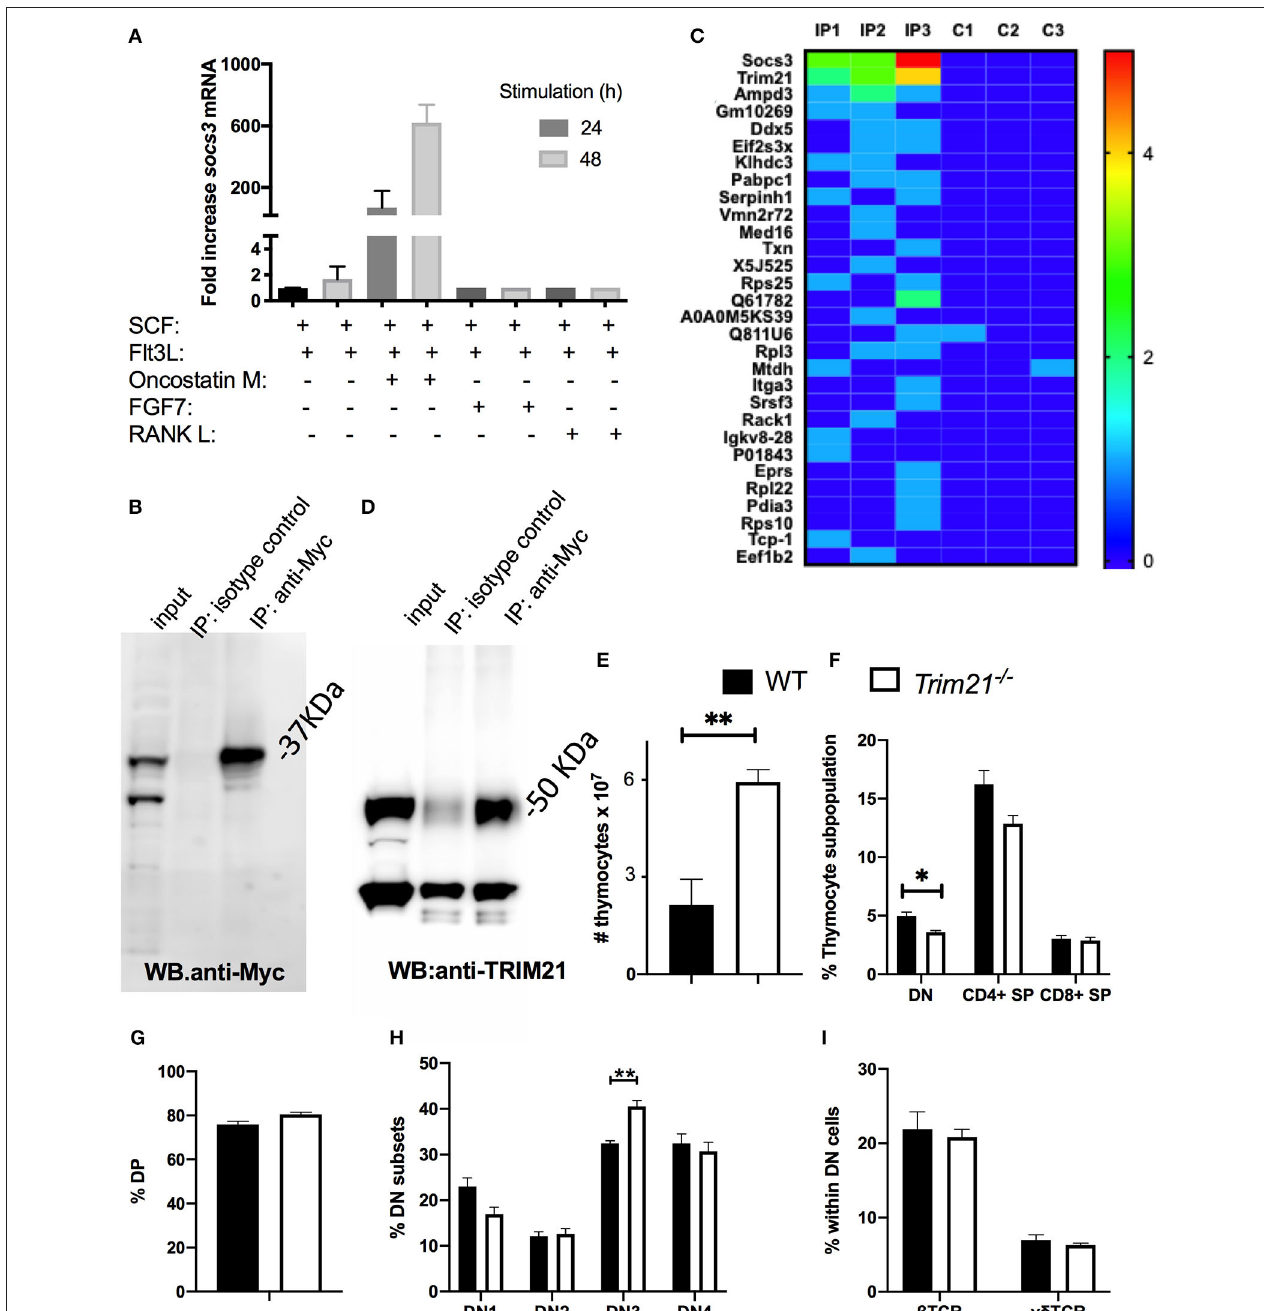
FIGURE 6 | SOCS3 in thymic epithelial cells binds to TRIM21. (A) OP9-DL1 cells were incubated with either SCF, Flt3L, OMS, FGF7, or RANK. Twenty four and forty eight hour after stimulation, the total mRNA was extracted and Socs3 and Hprt mRNA levels measured by real time RT-PCR. The mean relative fold induction of Socs3 / Hprt mRNA ratio in stimulated and unstimulated cells are depicted. (B) OP9-DL1 cells were transfected with an Myc-SOCS3 plasmid. The western blot of transfected cell lysates before and after immunoprecipitation with anti-myc or an isotype controls is shown. (C) Heat map of ranking proteins identified after tandem mass spectrometry in immunoprecipitates from socs3- transfected OP9-DL1 cells with anti-myc or isotype controls. Three replicates per condition were analyzed. Ranking was calculated with an algorithm weighing the number of replicates in which the protein was detected in the IP and in the control group, the number of peptide spectral matching the protein, the number of unique peptides and the intensity (the area under the curve). (D) Anti-SOCS3 or anti-isotype immunoprecipitates were analyzed by immunoblot using anti-TRIM21. (E) The mean number of WT and Trim21 − / − thymocytes ± SEM are depicted ( n ≥ 5 per group). Differences between groups are significative (** p ≤ 0.01 unpaired Student’s t -test). (F,G) The mean frequency of thymic DN, DP, and SP subpopulations ± SEM in Trim21 − / − and WT thymi ( n = 5 per group). (H) The mean of frequency ± SEM of DN1-DN4 subpopulations (defined by CD44 and CD25 expression) in trim21 − / − and WT thymi (n ≥ 5 per group). (I) The mean % of β and γδ TCR + cells within the DN thymocytes of WT and trim21 − / − mice ( n ≥ 5 per group). Differences between groups are significant at ** p ≤ 0.01 unpaired Student’s t -test.